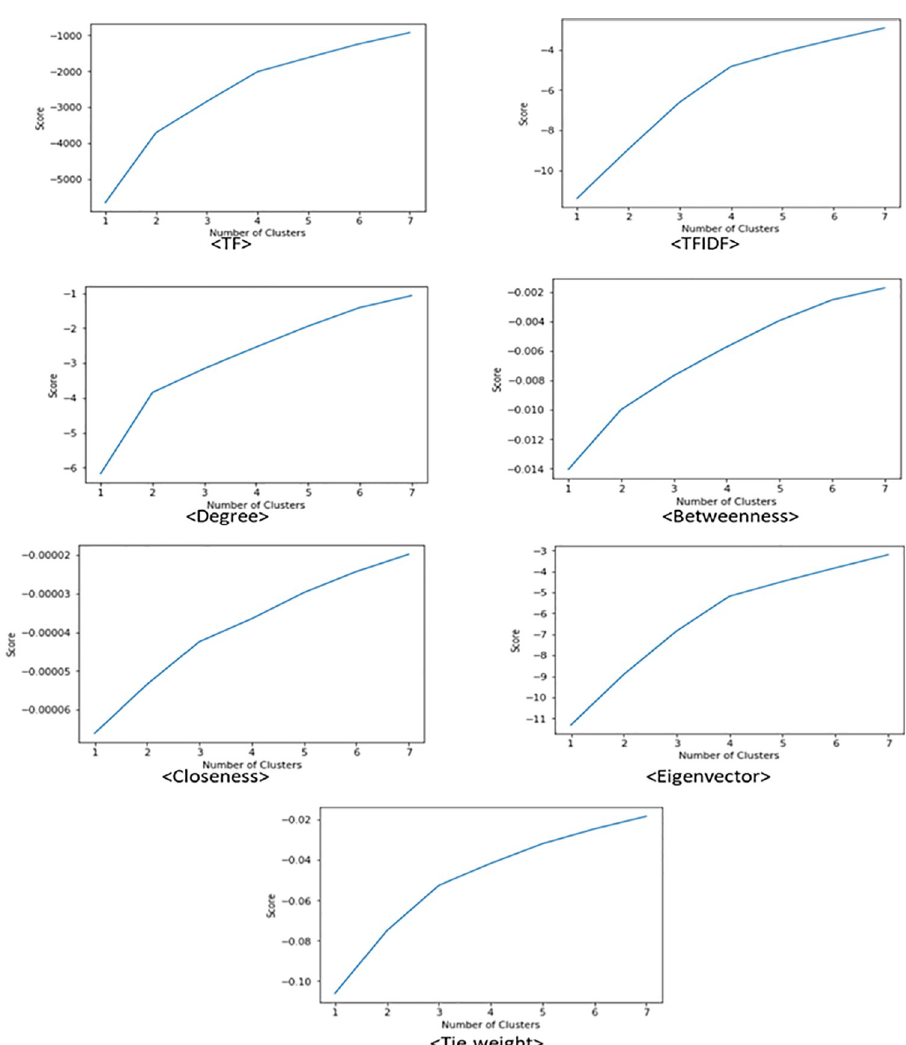
Fig 3. Score plots of each method. Note : Horizontal axis: Number of Clusters, Vertical axis: Score.